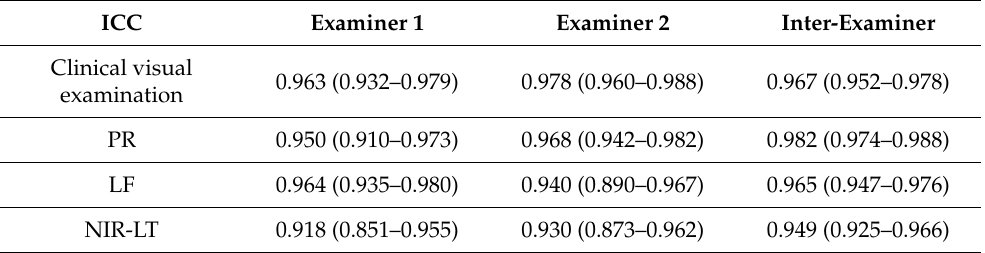
Table 2. ICC values for intra- and -inter examiner variability each diagnostic method